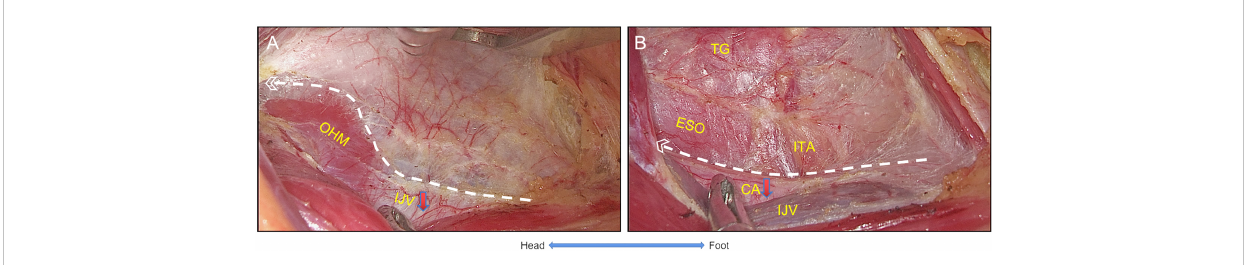
FIGURE 2 The settlement of carotid sheath. (A) The visceral fascia was dissected longitudinally to expose the OHM and IJV, and IJV was settled. (B) The inner side of the carotid sheath and the visceral fascia were dissected longitudinally, the CA was settled, and then ITA and esophagus were exposed. OHM,